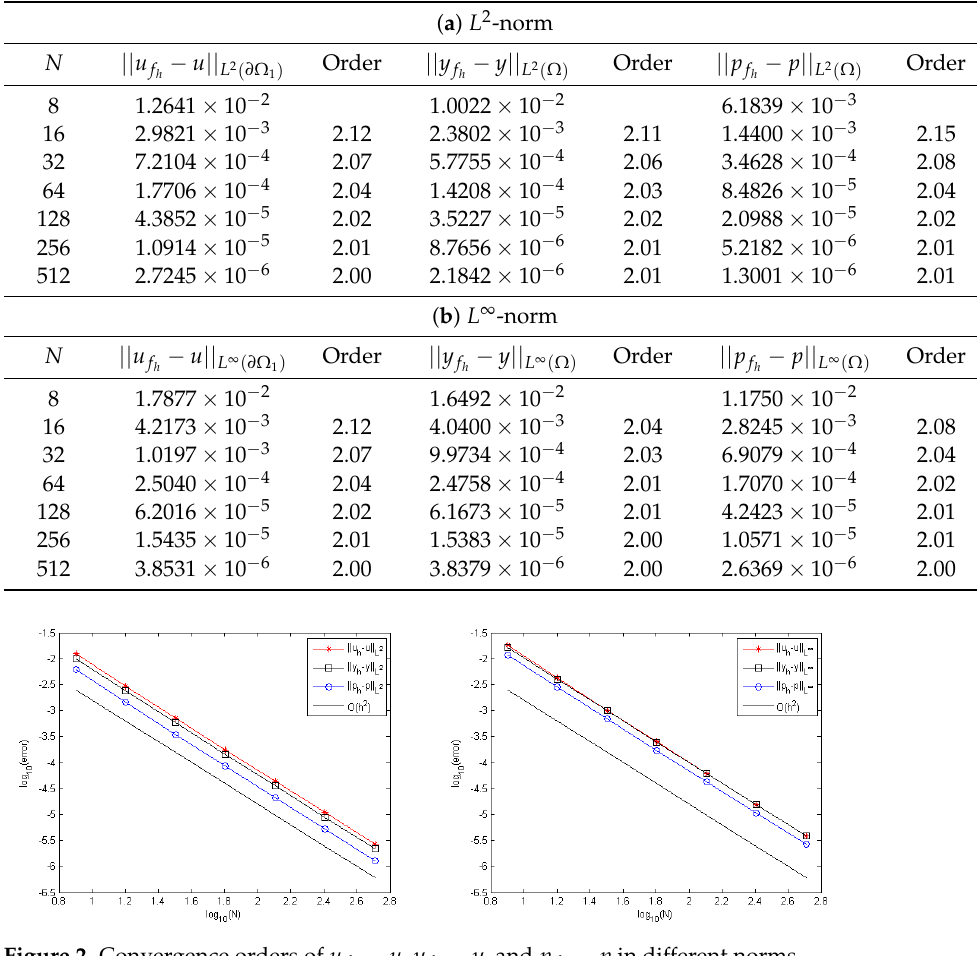
Figure 2. Convergence orders of u f